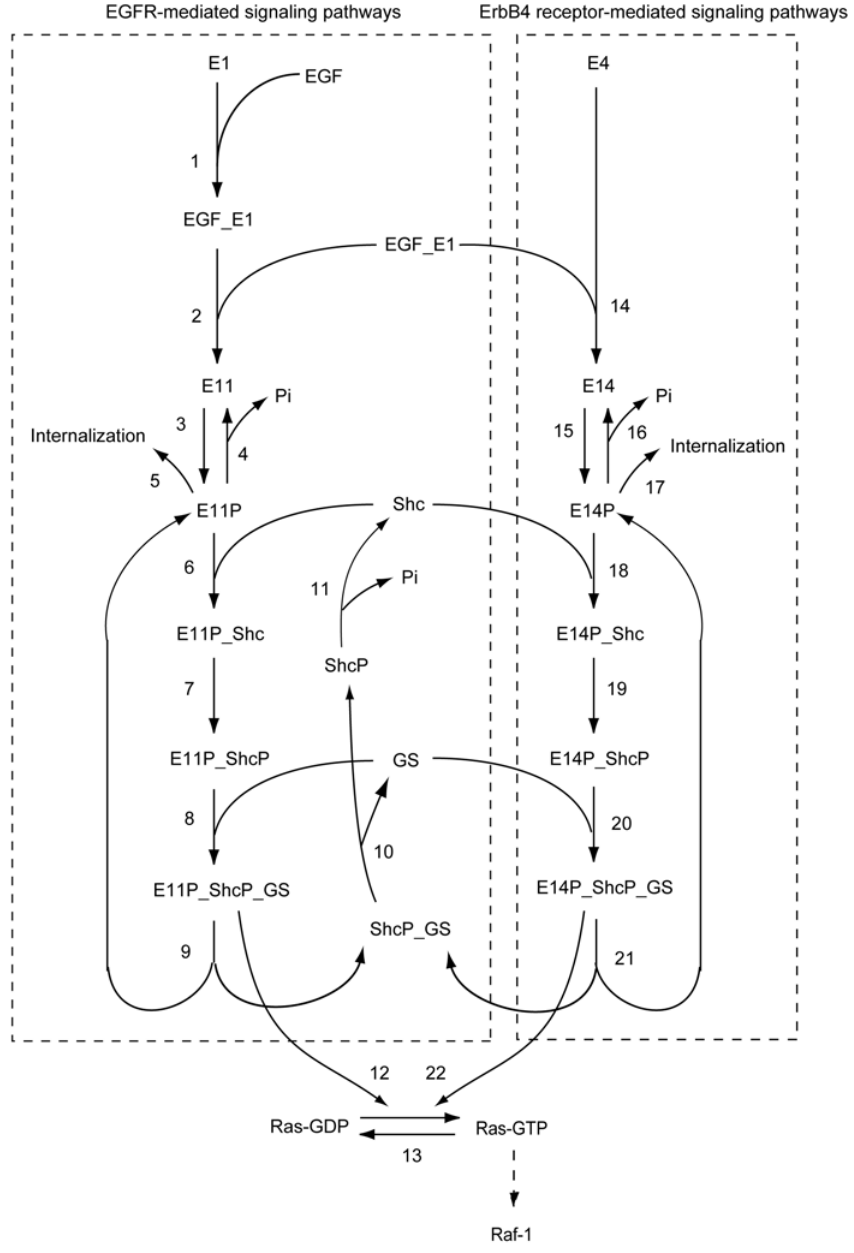
Figure 6. Detailed upstream model of EGFR/ErbB4 heterodimer-mediated Ras activation. The pathways in the left and right boxes are mediated by the EGFR homodimer and the EGFR/ErbB4 heterodimer, respectively. Ras activation is regulated by these two pathways via steps 12 and 22. When performing parameter estimation of total concentrations and kinetic parameters for the E1/4 cells, all parameters were estimated. On the other hand, the concentration of the ErbB4 receptors was set to zero for E1 cells, while other unknown parameters were considered to be identical as those for the E1/4 cells. Numbers shown correspond to the kinetic equations in Table S7.